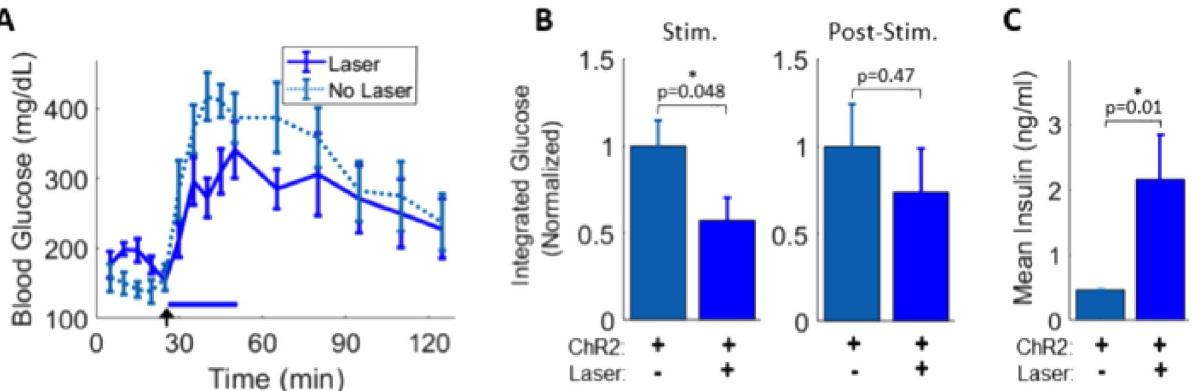
Figure 2. Direct optogenetic control of pancreas innervation following glucose elevation. ( A ) Blood glucose response in ChAT-ChR2 mice with and without laser stimulation (blue bar, 473 nm, 5 ms pulses, 20 Hz) following intraperitoneal glucose bolus injection (black arrow). ( B ) Integrated area under the glucose response curve during the stimulation period (left) and during the post-stimulation period (right). ( C ) Blood insulin concentration sampled immediately following stimulation is significantly increased (~ twofold; p = 0.01) in the laser-stimulated ChAT-ChR2 group relative to non-laser-stimulated ChAT-ChR2. Data in A-C presented as the mean over n = 8 recordings (with light) and n = 7 recordings (without light). Error bars represent standard error in the mean.